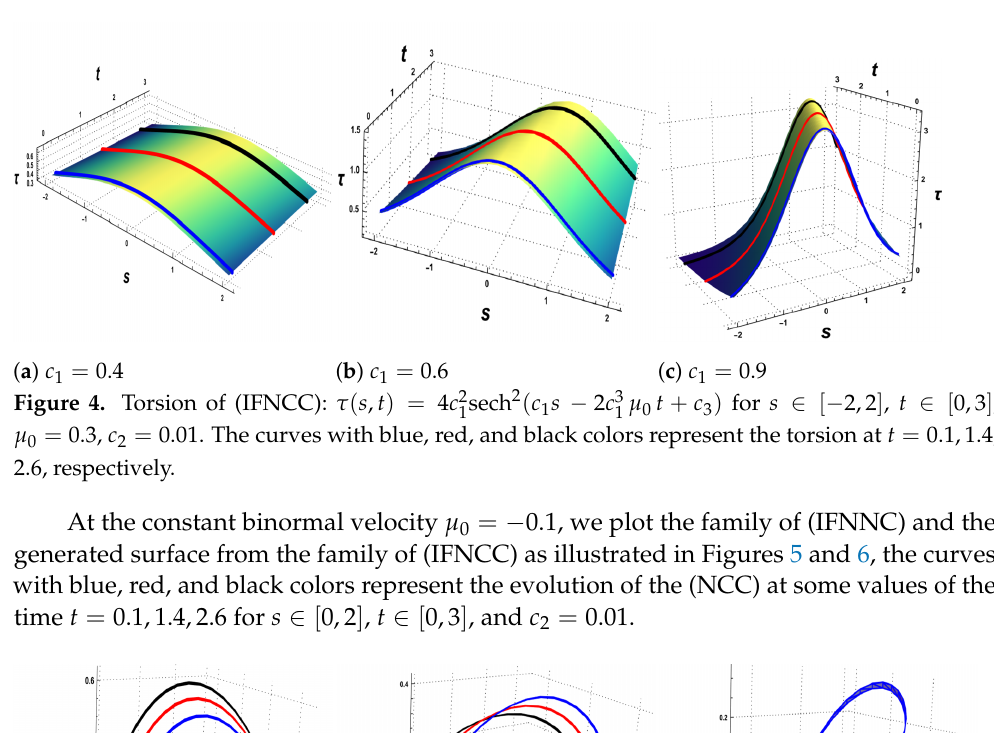
Figure 3. Torsion of (IFNCC): τ ( s , t ) = 4 c 2 µ 0 = − 0.1, c 2 = 0.01. The curves with blue, red, and black colors represent the torsion at t = 0.1,1.4, 2.6, respectively.